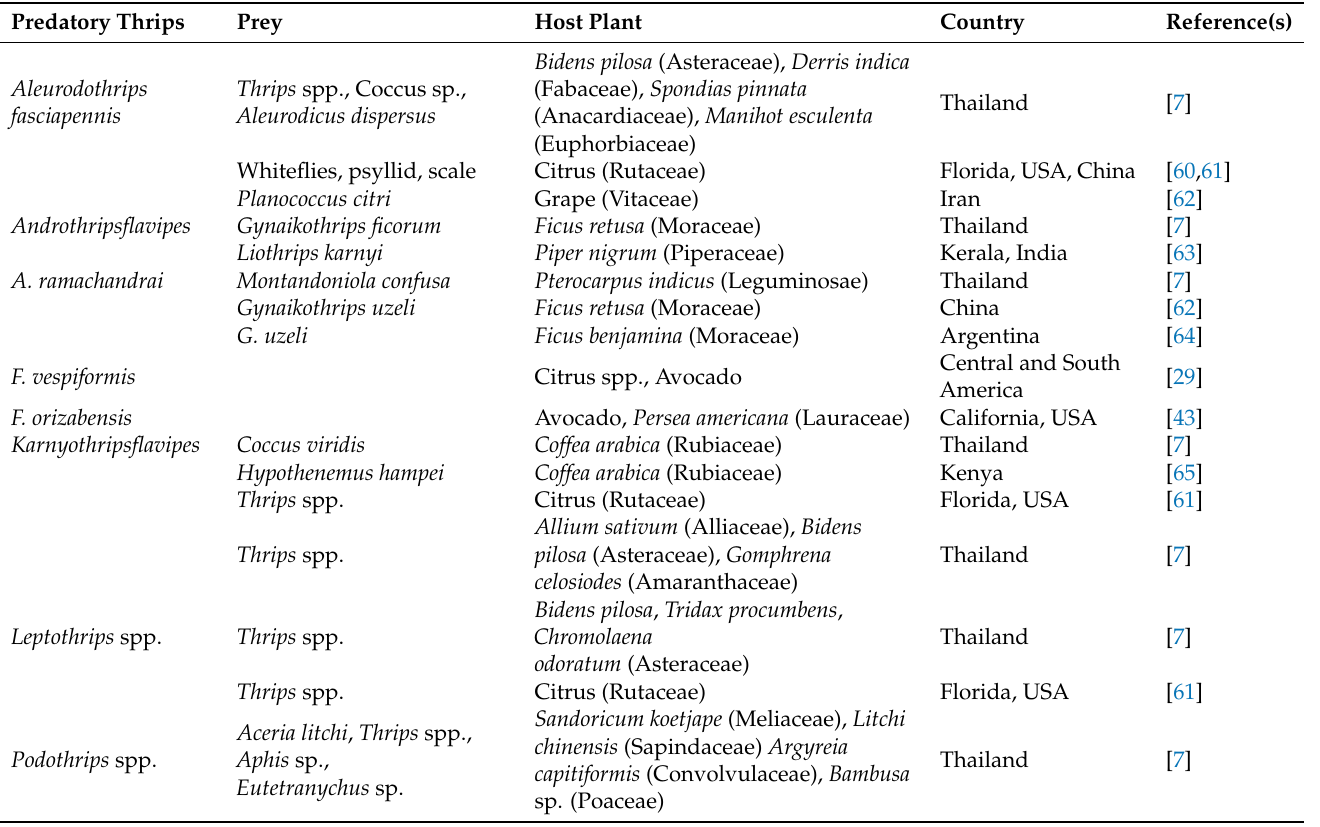
Table 4. Host plant associations of Franklinothrips and other predatory thrips with their